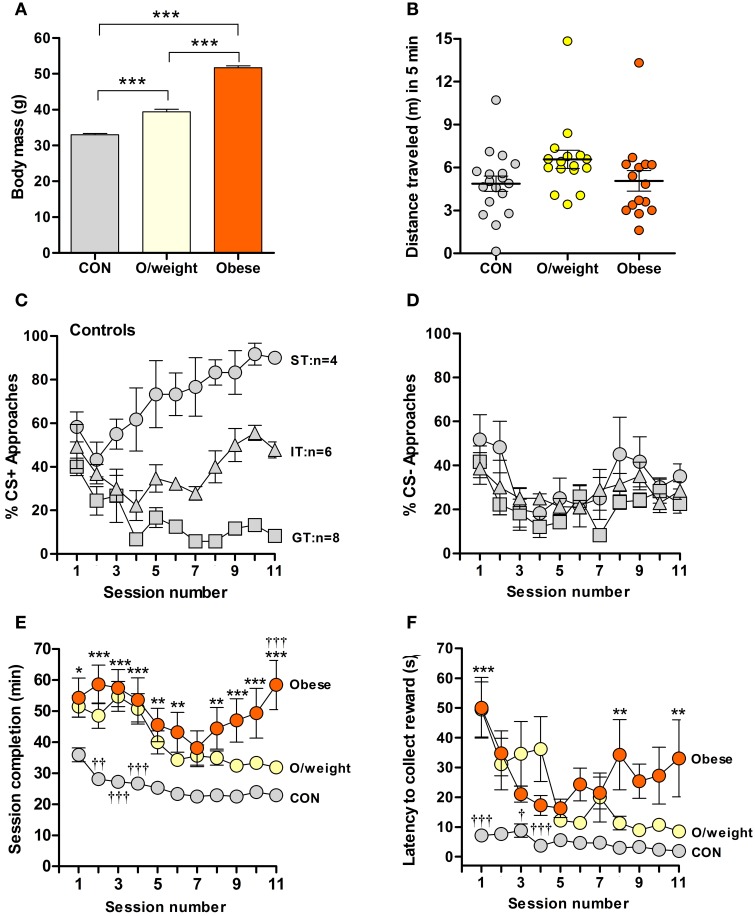
Overweight and obese mice show poor acquisition of food-rewarded pavlovian conditioned learning. (A) Body masses of control (CON; normal chow, n = 18), overweight (O/weight; low fat-high carbohydrate diet; n = 16) and obese mice (high fat-high carbohydrate diet, n = 16) at the start of experimentation. (B) Locomotor activity, measured in an open field arena, of CON, O/weight and Obese mice before behavioral testing commenced. (C) Relative number of CS+ approaches and CS- approaches (D) during each session; only CON mice displayed different conditioned responses (cf. Harb and Almeida, 2014), characterized as sign-tracking (ST, predominantly approached the CS+; n = 4), goal-tracking (GT, predominantly approached the US; n = 8), and intermediate-tracking (IT, alternated between CS+ and US with approximately equal frequency; n = 6). Autoshaping was monitored over 11 sessions; in each session, mice received 15 CS+ and 15 CS- presentations. (E) Time in min needed to complete successive autoshaping sessions. (F) Mean latency (s) to retrieve food reward during consecutive training sessions. Data are means ± s.e.m. ***In (A) denotes p < 0.001. *, **, ***In (E,F) indicate differences between CON and obese groups at p < 0.05, 0.01, and 0.001, respectively. †, ††, †††In (E,F) indicate differences between O/weight mice vs. CON and Obese mice at p < 0.05, 0.01, and 0.001, respectively.